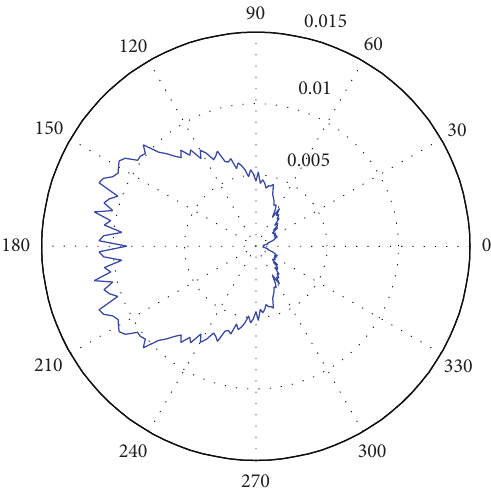
Figure 12: Discrete probability density function of the relative horizontal reflector position (RX heading in 𝑥 direction). This exampleshowstheresultfromdatacollectedinthecenterofMunich with the Zeppelin at 30 ∘ elevation.